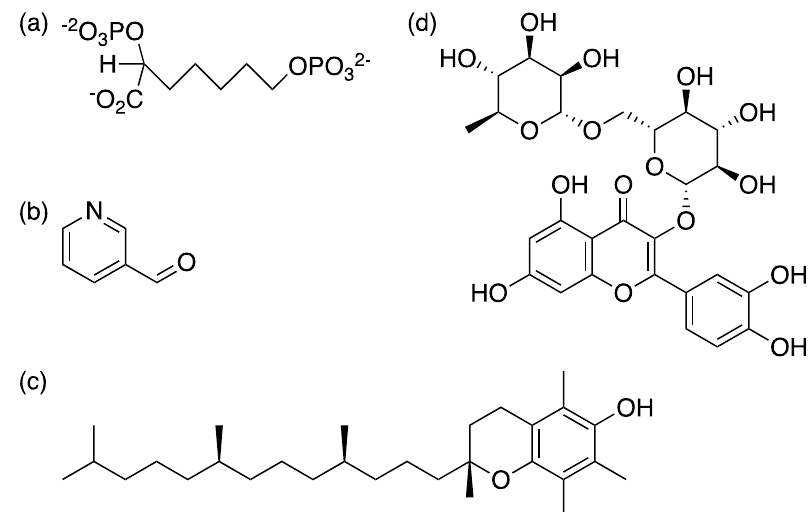
Figure 5. Linear chemical structures of Mt DAHPS inhibitors. ( a ) simplified bisphosphate, ( b ) 3-pyridine carboxyaldehyde, ( c ) α -tocopherol, ( d ) rutin.